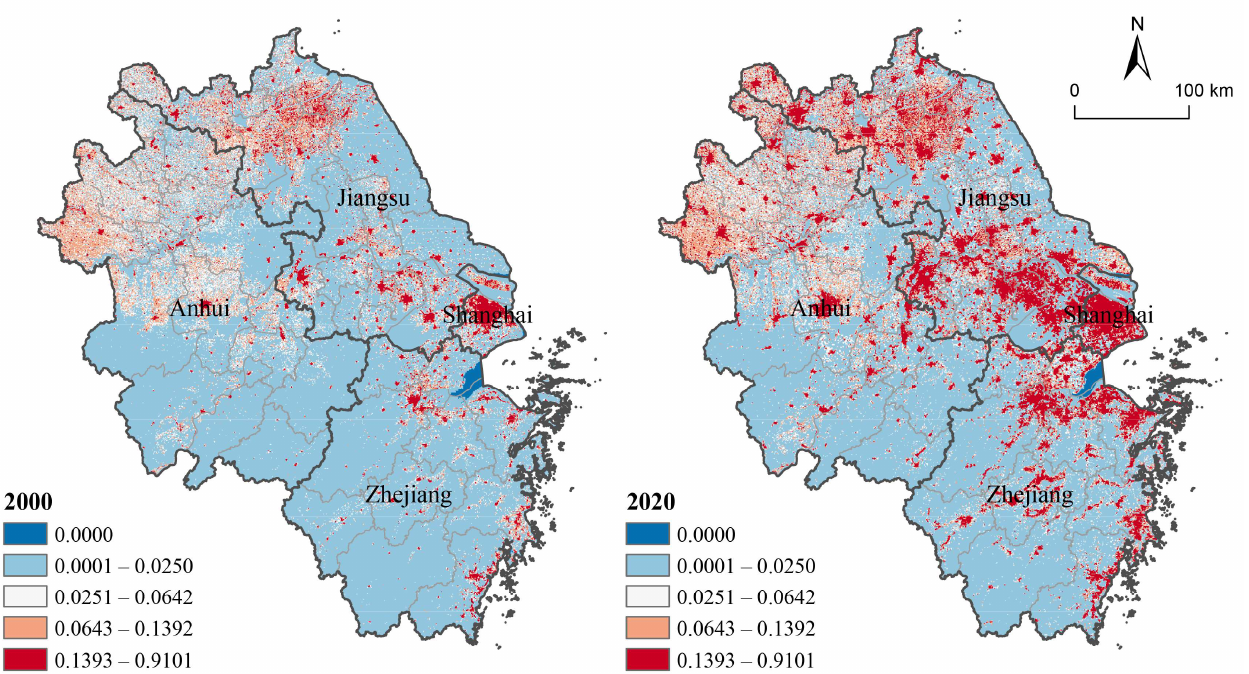
Figure 4. CUL of YRD during 2000–2020. High spatial variation of urbanization could be found among all provinces of YRD (Figure 4). Shanghai had the highest CUL and a broader distribution of highly urbanized ar- eas showing a typical planar distribution. The CUL of Jiangsu was second only to Shanghai, and the spatial distribution of its CUL was relatively uniform, showing a combination of planar and point patterns. The CUL of Zhejiang province was lower, but increased rapidly with a 204.31% increment from 2000 to 2020. Its urbanization was characterized by cen- tralization, with highly urbanized areas densely distributed in the plains along Hangzhou Bay, Fuchun River and the southeastern coastal areas, which was a typical belt distribution. Anhui had the lowest CUL and the slowest urbanization, and its CUL increased 61.23% during the past 20